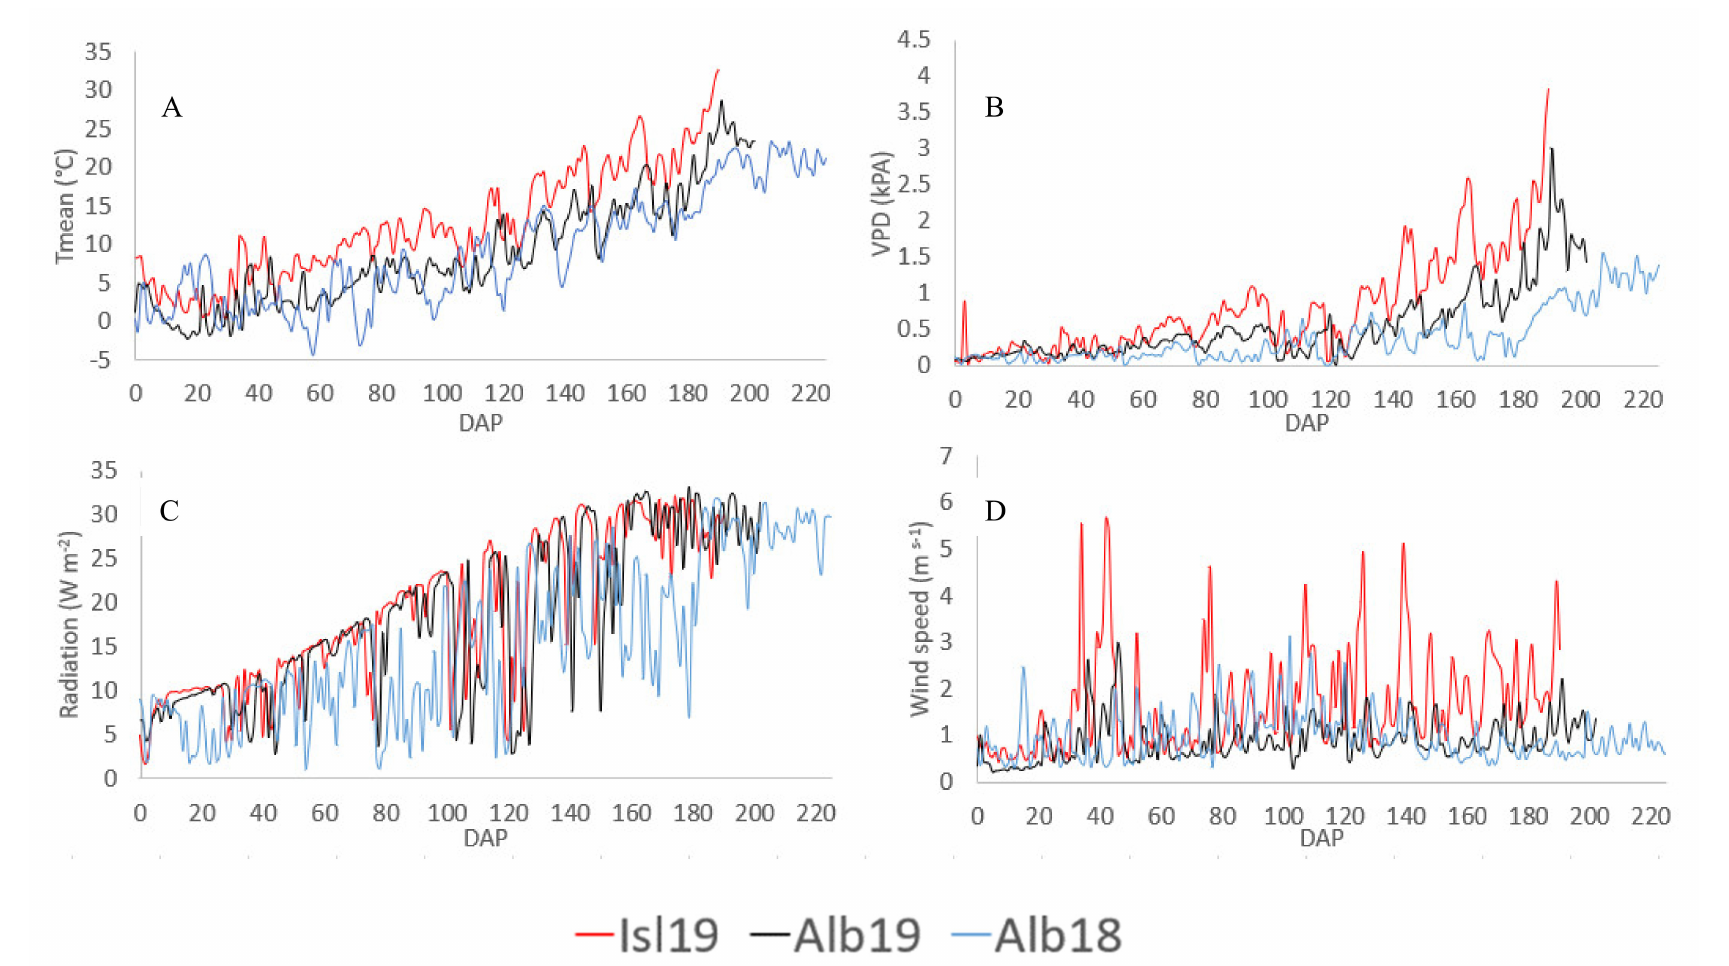
Figure 1. Weather conditions at the di ff erent experiments during the two seasons: ( A ) Average daily temperature (Tmean); ( B ) Average daily vapor pressure deficit; ( C ) Average daily radiation and ( D ) Average daily wind speed. X -axis are days after planting (DAP). Red color corresponds to the assay conducted at La Isla in 2019 (Isl19); Black color corresponds to the assay conducted at Albaladejito in 2019 (Alb19); Blue color corresponds to the assay conducted at Albaladejito in 2018